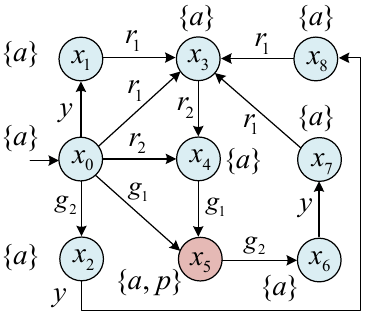
Figure 9. Supervisor S ∗